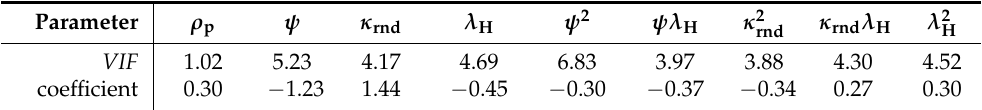
Table 7. Variance inflation factor of the remaining explanatory variables and regression coefficients for the standardized